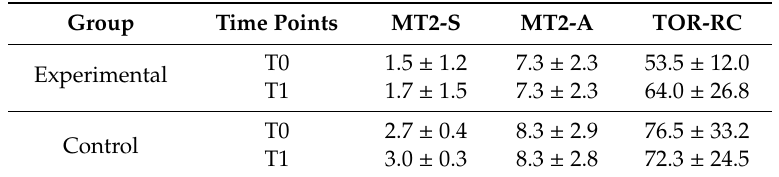
Table 4. Statistical results of the MT2 and TOR tests at baseline and at the end of the reading sessions ( p > 0.05). Mean ± Standard Deviation is reported.